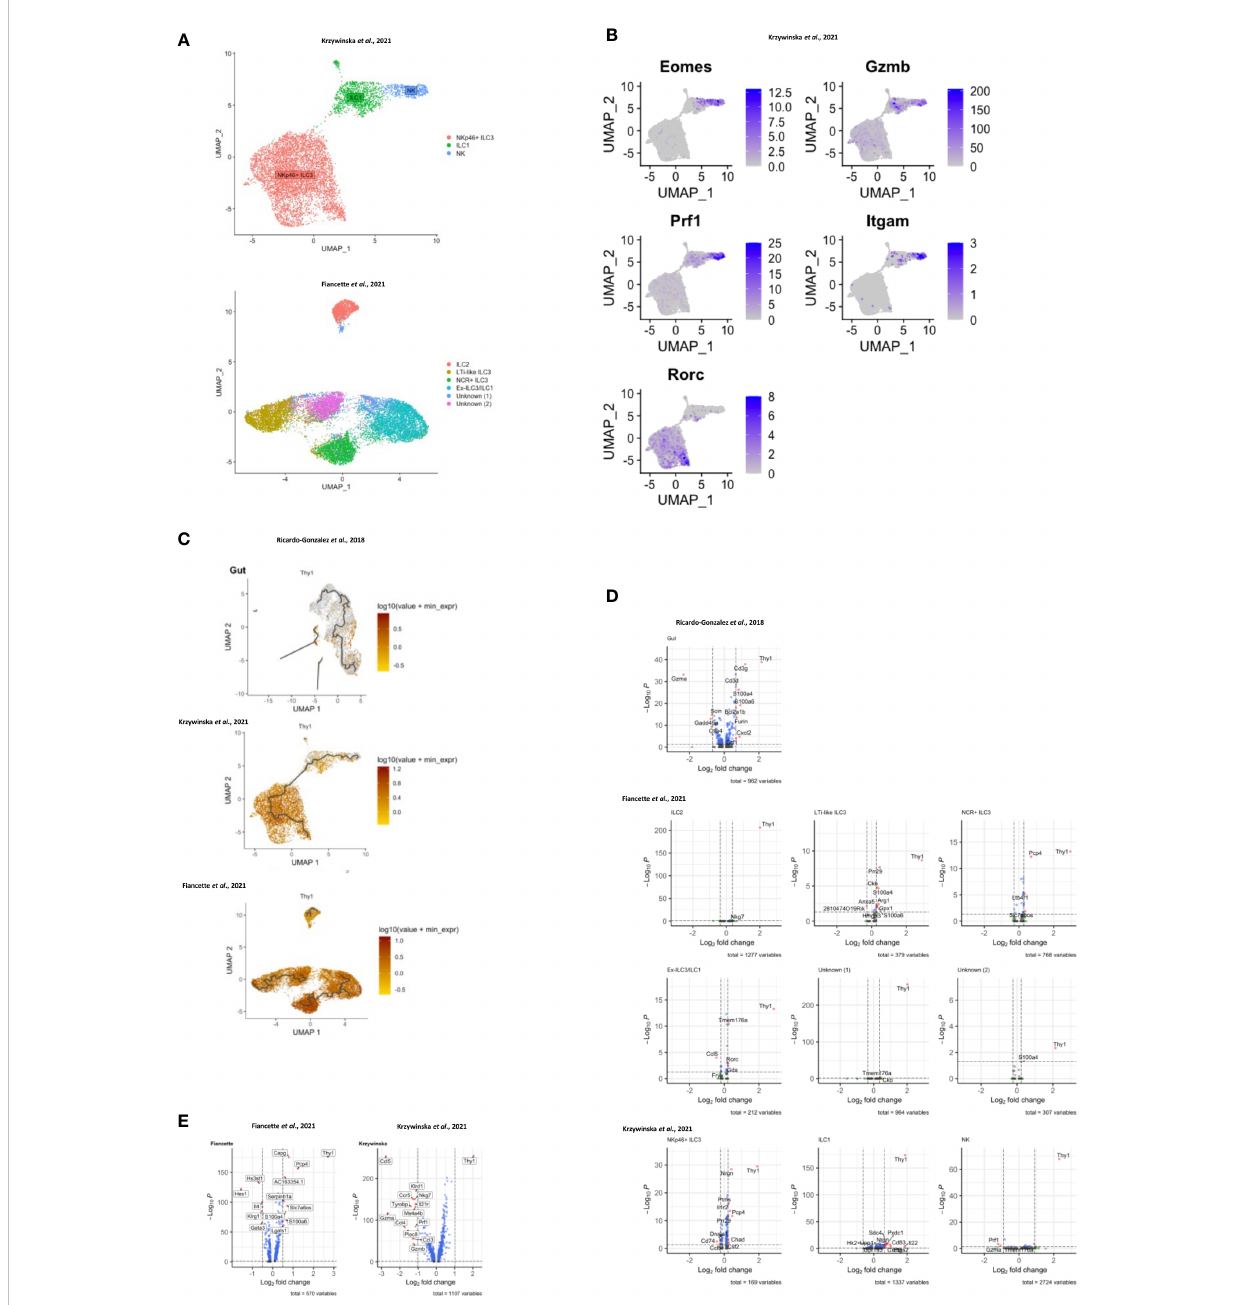
FIGURE 3 Transcriptomic analyses of CD90 expression in intestinal ILC. scRNA-seq data sets of intestinal ILC from published studies (47, 49, 55) were employed to analyze expression of Thy1 (encoding CD90) across ILC subsets and its role on the global transcriptional pro fi le. (A) UMAP plots of ILC subset annotation from the scRNA-seq data sets of the (47, 55) studies. (B) UMAP analyses of gene expression in the ILC subset clusters in the data set obtained from (55). (C) UMAP analysis of Thy1 expression intensity in ILC subsets in the respective studies. A trajectory analysis along the Thy1 expression intensity was performed in the indicated ILC subsets. (D, E) Volcano plots comparing gene expression (log2 fold change and p adj ) between Thy1 high ILC versus Thy1 low/negative (D) ILC subsets, as annotated in the respective published data set, and (E) total ILC. The most differentially expressed genes are labelled. In order to generate the volcano plots the median normalized Thy1 expression across all datasets was calculated and used to delineate Thy1 high and Thy1 low/negative